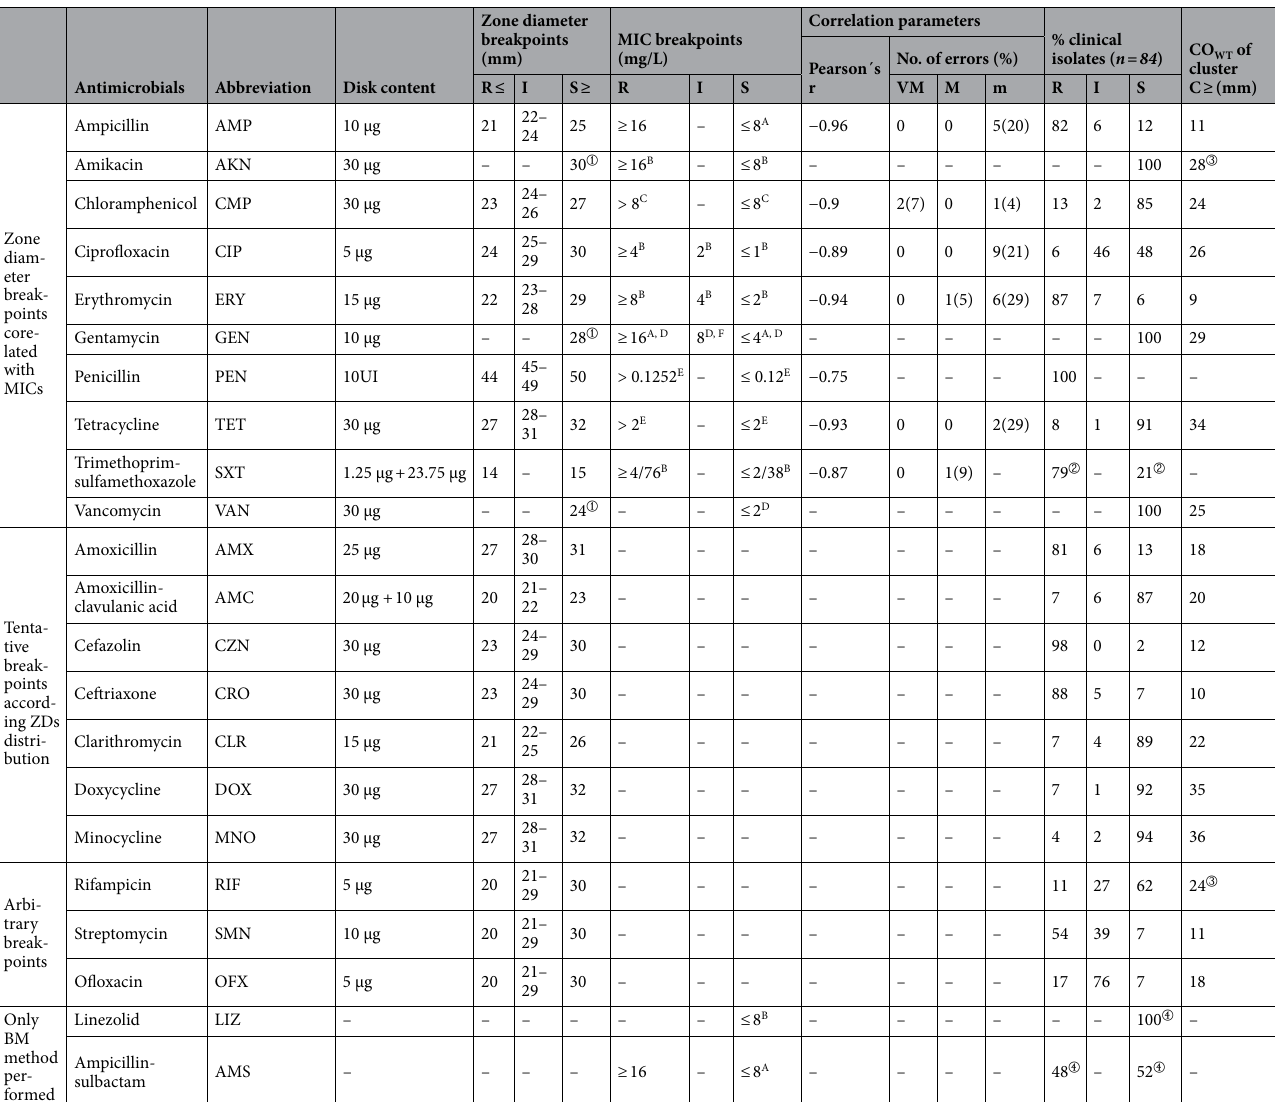
Table 2. Results of the correlation analysis between the standard broth microdilution method and the zone diameter distribution, and the results of AST of clinical isolates performed with the disk diffusion method. List of antibiotics, their abbreviations, and disk concentration used in the study are provided. Antibiotics are grouped into categories according to zone diameter breakpoint settings. Table shows the proposed zone diameter breakpoints based on ZD-MIC correlation analysis altogether with ZDs distribution among clinical strains, proposed MIC breakpoints according to available breakpoints values in CLSI and EUCAST guidelines and according to ZDs distribution among clinical strains. Parameters of the correlation analysis are provided: Pearson correlation coefficient (r), VM – very major error, false-susceptible by DD; M – major error, false- resistant by DD; m- minor error, one of the test results is intermediate and the other is susceptible or resistant. Antibiotic susceptibility distribution of clinical strains based on proposed ZD breakpoints and wild type cut-off (CO WT ) calculated for clinical strains in the cluster C. Abbreviations: R = resistant, I = intermediate susceptible, S = susceptible; ① minimum ZD values were proposed as susceptibility breakpoints (type strain DSM 40783 was excluded for vancomycin and BCCO 10_1638 for amikacin), since predominantly susceptible strains (BM method) were present; ② only 78 clinical isolates were included, cluster D was excluded; ③ abnormal standard deviation; ④ only 29 clinical isolates were tested. References: A—Larruskain, J., Idigoras, P., Marimón, J. M., Pérez-Trallero, E. Susceptibility of 186 Nocardia sp. isolates to 20 antimicrobial agents. Antimicrob. Agents. Chemother. 55 , 2995–8 (2011); B—CLSI. Susceptibility testing of mycobacteria, and other aerobic actinomycetes. 2nd Ed. CLSI Guideline M24 (2011); C—Dragomirescu, C. C. et al. Antimicrobial susceptibility testing for Corynebacterium species isolated from clinical samples in Romania. Antibiotics 9 , 1–9 (2020); D—CLSI. Methods for antimicrobial dilution and disk susceptibility testing of infrequently isolated or fastidious bacteria. 3rd Ed. CLSI Guideline M45 (2015); E—EUCAST. Testing Breakpoint tables for interpretation of MICs and zone diameters. Available from: https:// www. eucast. org/ filea dmin/ src/ media/ PDFs/ EUCAST_ files/ Break point_ tables/ v_ 10.0_ Break point_ Tables. pdf